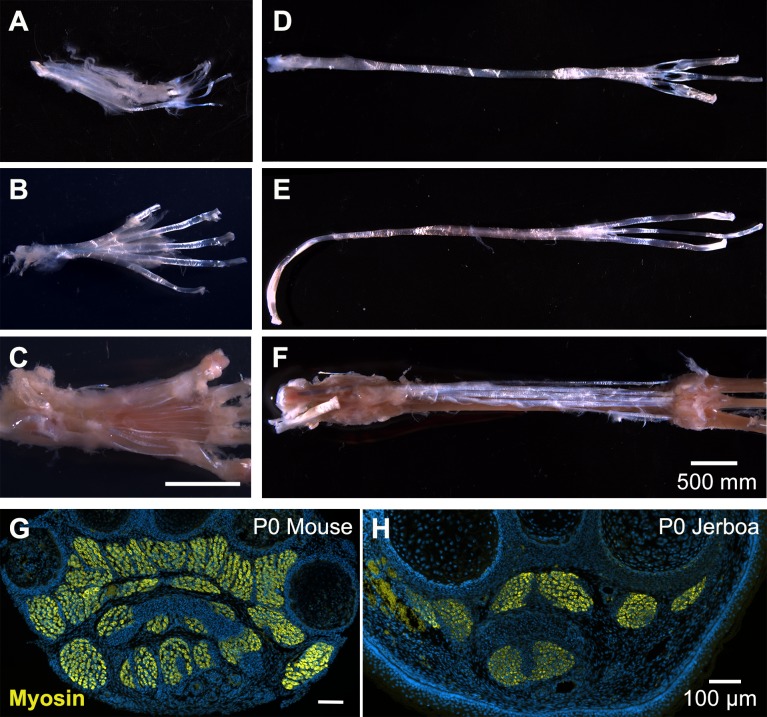
Anatomy of mouse and jerboa foot.Related to Figures 1 and 2. (A) In the adult mouse, tendon of the flexor digitorum superficialis supports the m. flexor digitorum brevis with distal tendon branches that each divide in two before inserting into either side of the base of the middle phalanx of each digit. (B) Dorsal to this layer, the tendon of the flexor digitorum longus splits upon entering the foot and carries the m. lumbricales. Each flexor digitorum longus tendon emerges distally from between the branches of each flexor digitorum superficialis tendon and inserts into the base of each of the terminal phalanges. (C) The m. interossei have a common tendon that originates in the tarsus, branches into each of the interosseus muscles, and inserts distally into the base of each of the proximal phalanges. (D–F) The adult jerboa retained the tendons of (D) the flexor digitorum superficialis, (E) the flexor digitorum longus, and (F) the interossei, but all are devoid of muscle. (G, H) A representative transverse section illustrates the presence of foot muscle in the newborn (G) mouse and (H) jerboa.